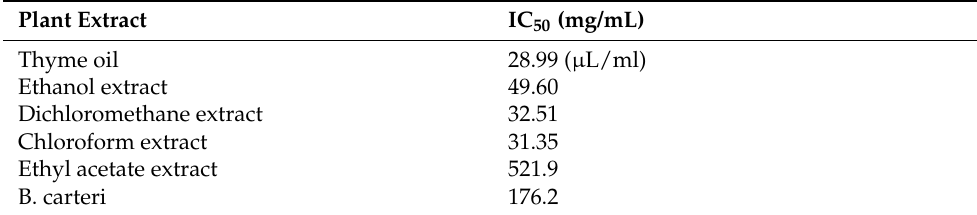
Figure 4. Mycelial growth % inhibition with different concentrations of T: thyme oil, E: ethanol, D: dichloromethane, C: chloroform, EA: ethyl acetate, B C: B. carteri , N: nystatin, DM: DMSO. Table 1. IC 50 of different plant extracts against F. oxysporum.